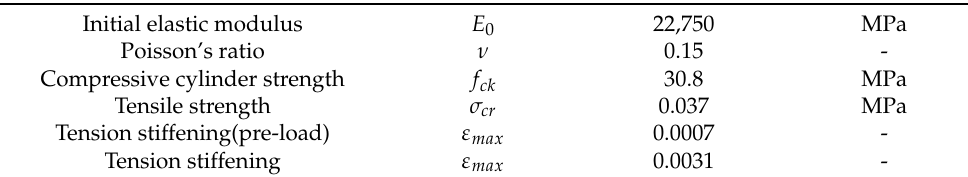
Table 2. Concrete parameters adopted in numerical